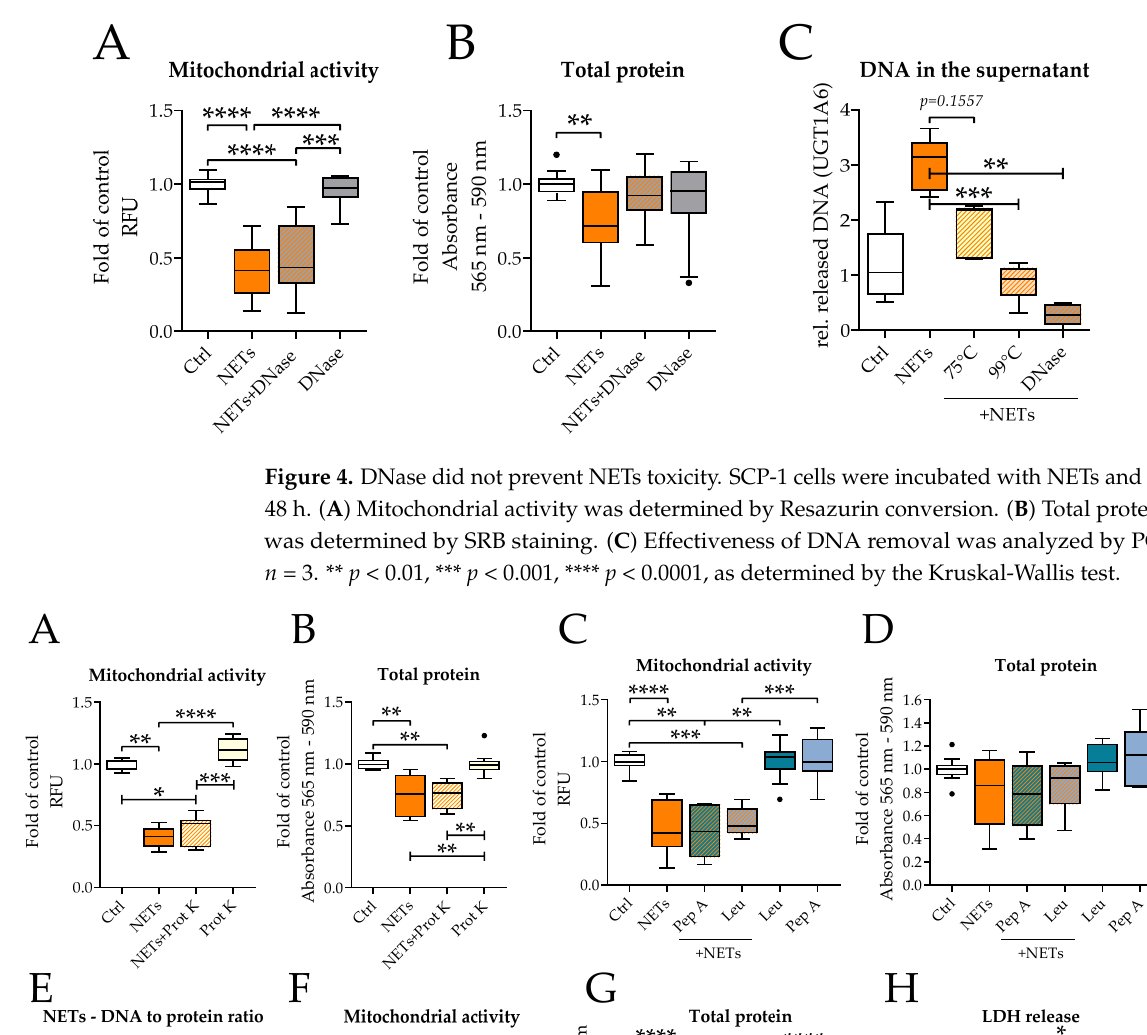
Figure 5. Inhibition of proteases or histones did not prevent NETs toxicity. ( A , B ) SCP-1 cells were incubated with 0.5 ng/µL of NETs and 0.5 µg/mL of Proteinase K. After 48 h, mitochondrial activity